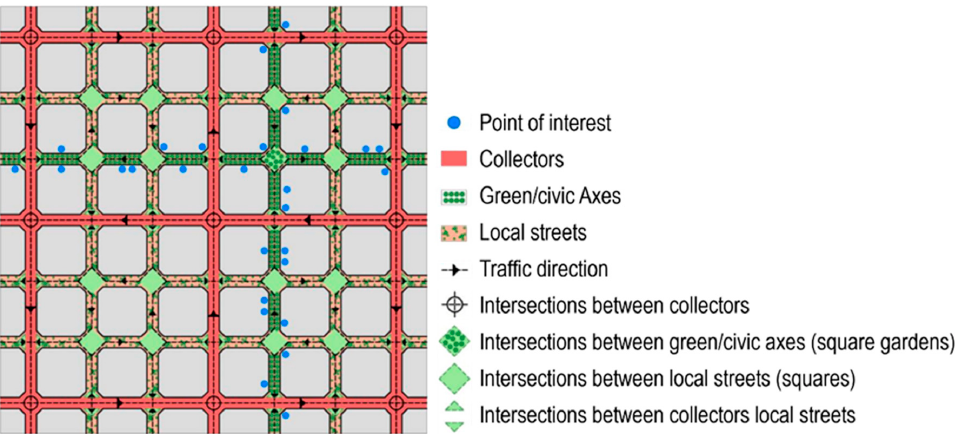
Figure 8. Explanatory diagram of the introduction of the green/civic axes on the model of the organization in superblocks of three by three of the homogeneous grid of the urban expansion. Source: Ajuntament de Barcelona [51].